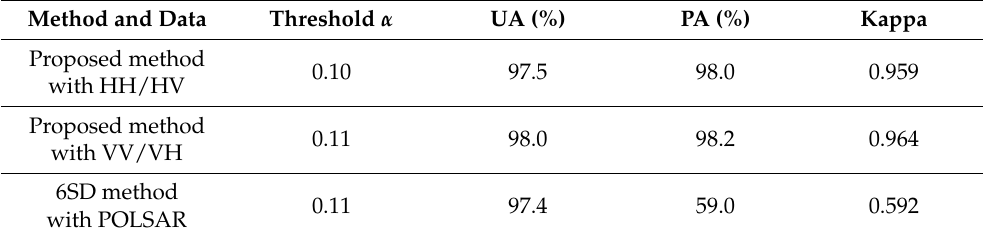
Table 8. Forest classification performance using a window size of 3 × 6 pixels at Rio